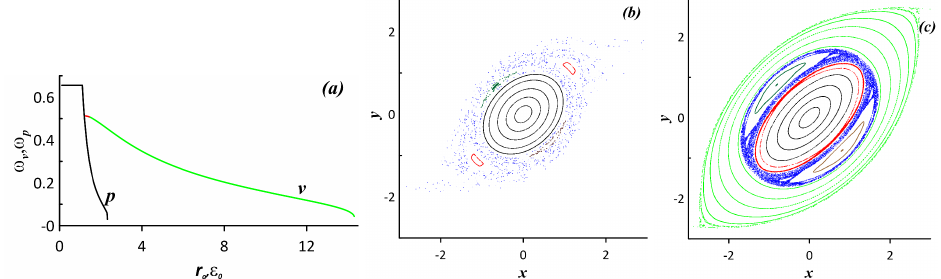
Figure 31. ( a ) The same as in Figure 29: ( b ) e = 0.05, γ = 0 and the vortex oscillating (cid:101) = 1.2141734; and ( c ) e = 0.05, γ = 0 and the vortex rotating (cid:101) =